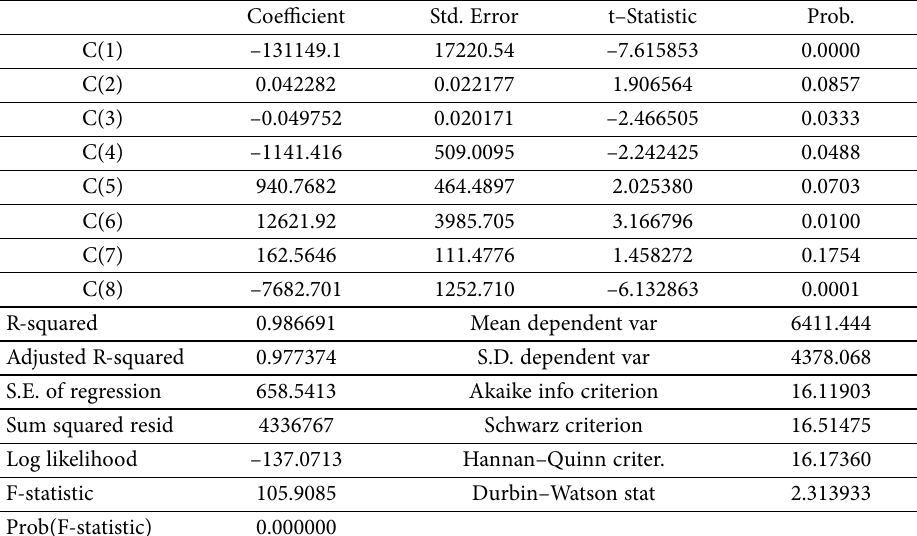
Dependent Variable: EMIGRAUSTRIA Method: Least Squares Sample: 1995 2013 Included observations: 18 after